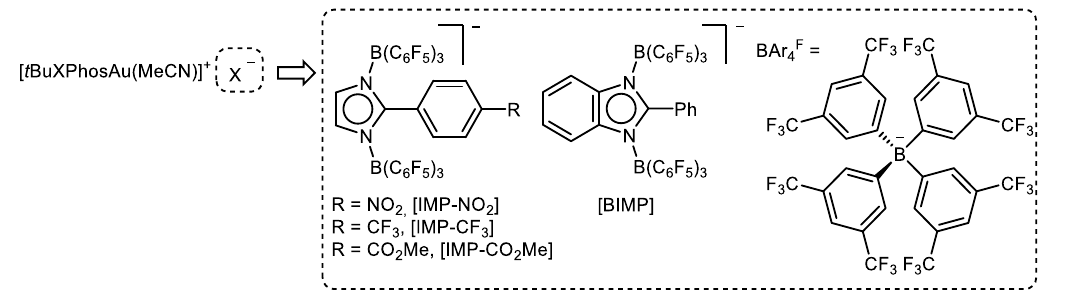
Figure 4. Gold complexes with imidazolyl-phenyl (IMP) anions.